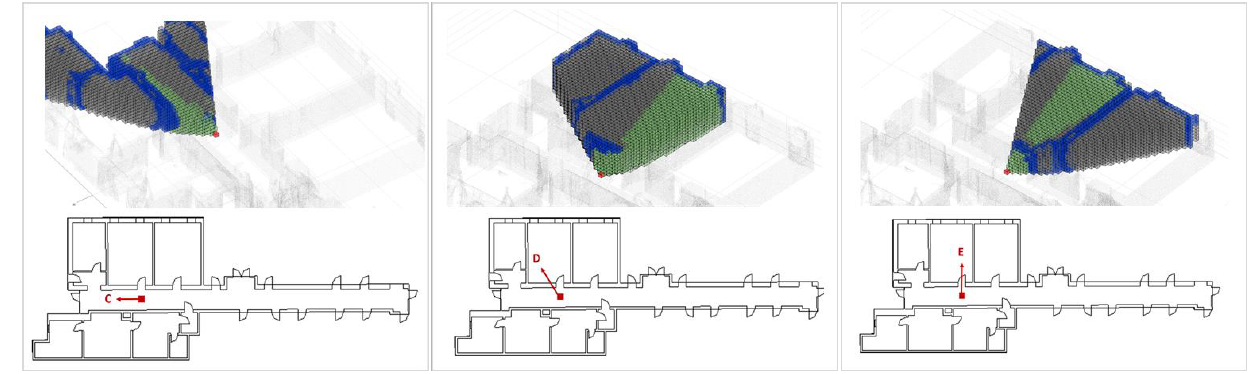
Figure 10. Visual space, considering mid-peripheral human vision, for one observer position (in red) and three different eye gaze direction (Test C, Test D and Test